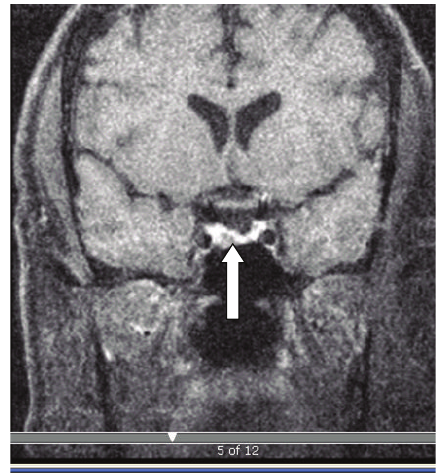
Figure 1: Pituitary MRI (post-contrast) showing microadenoma (thick